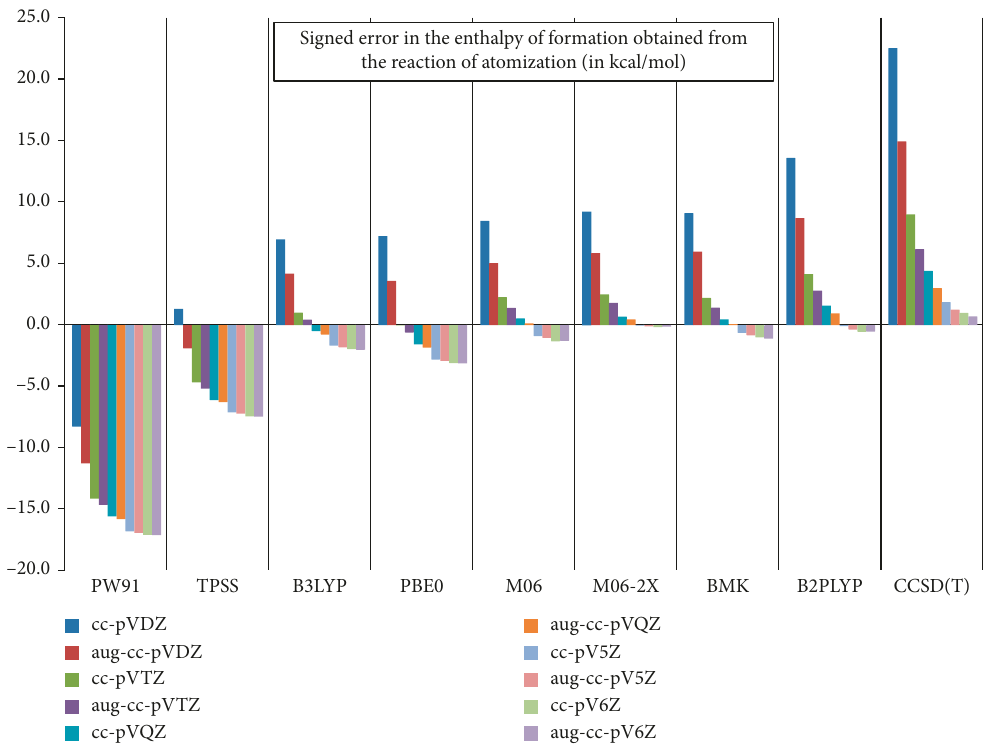
Figure 2: Difference between the enthalpy of formation of ClO at 298.15 K obtained from the reaction of atomization (1) and the ex- perimental value (in kcal/mol).